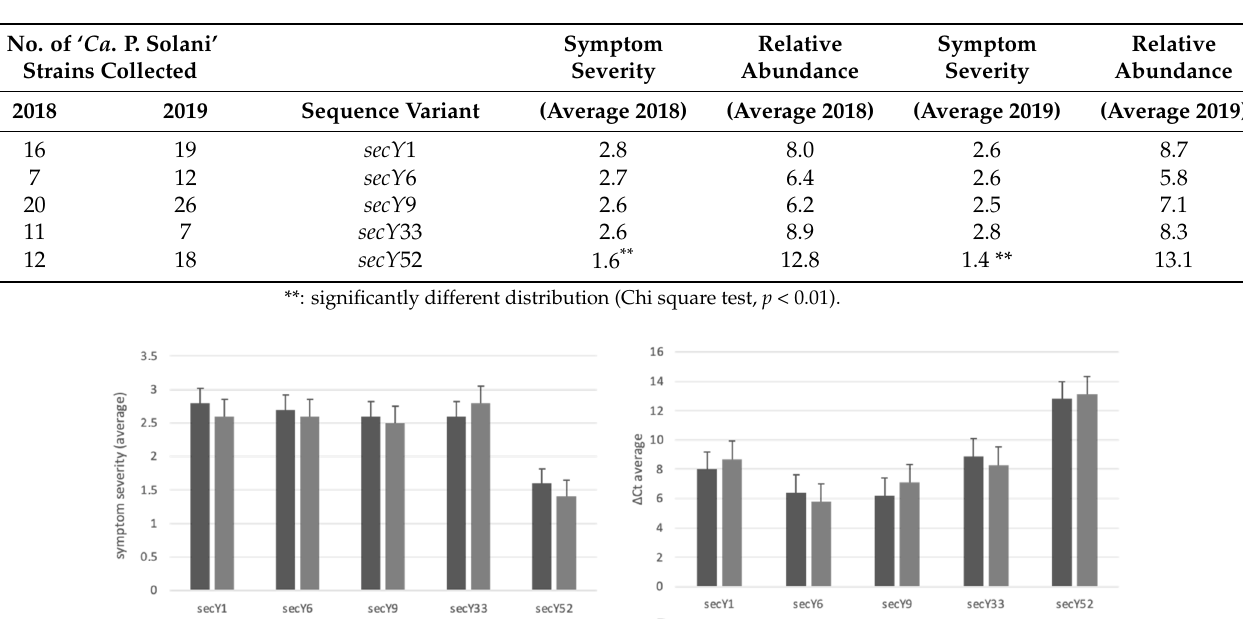
Table 1. Prevalence of secY gene sequence variants, carried by ‘ Ca. P. solani’ strains identified in 2018 and 2019, in vines showing different symptom severity (average).